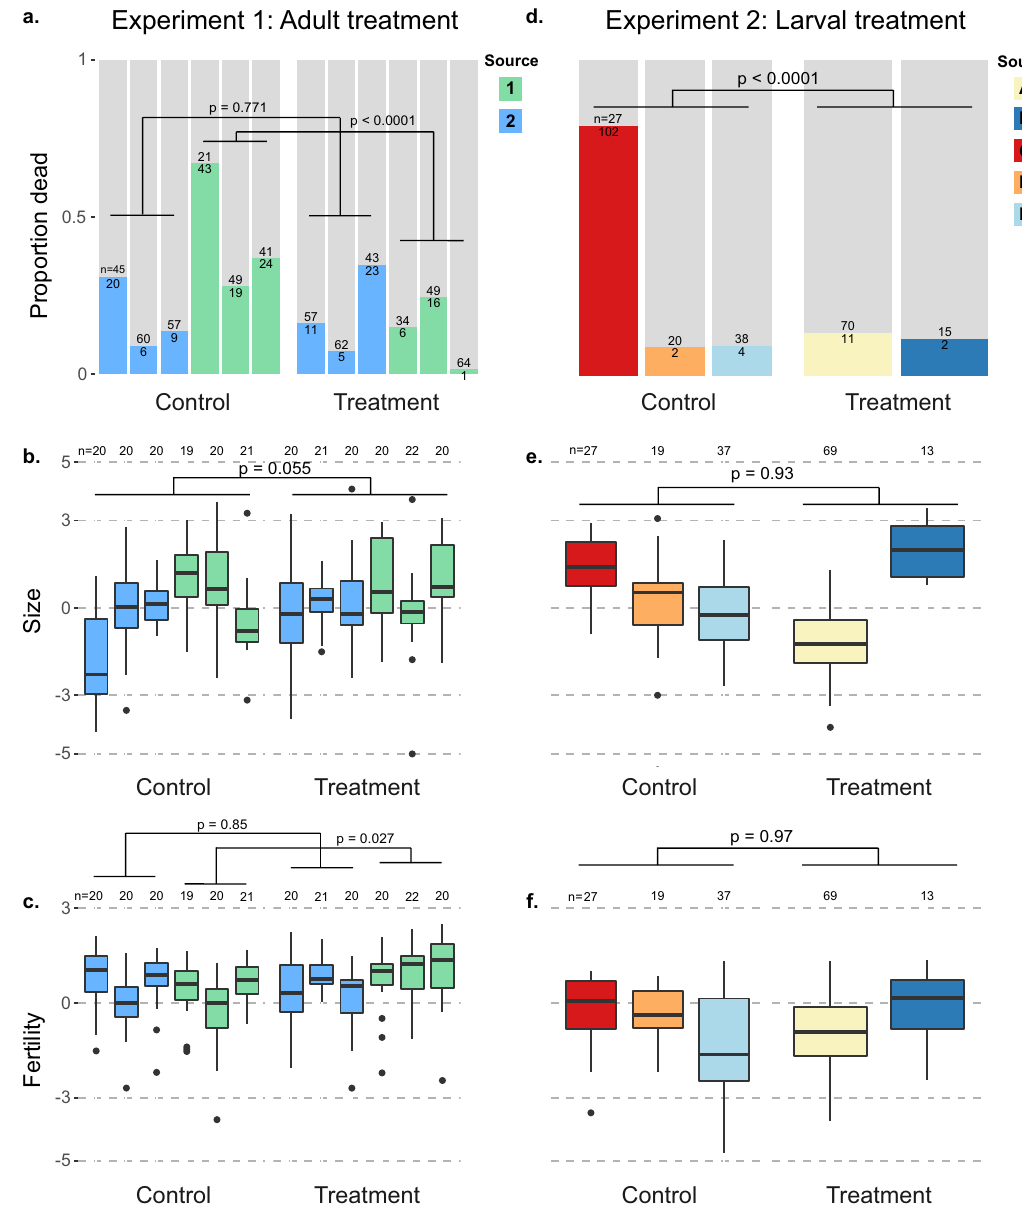
Fig. 2 No consistent effects of hive-level cocktail treatments via pollen on drone development or adult fostering. Within colonies, drones were exposed to pesticide-laced pollen patties either as adults (experiment 1) or as larvae (experiment 2). Unique drone source colonies are differentiated by colour. Mortality data are reported as proportion dead presented in colour, with live proportion presented in grey. Mortality differences were evaluated with χ 2 tests, whereas size and fertility were evaluated using linear mixed models (see Methods for speci fi c models). Boxes represent the interquartile range, bars indicate the median, and whiskers span 1.5 times the interquartile range. Sample sizes ( n ) are printed at the column break for the mortality tests ( a and d ) and along the top of each box plot ( b , c and e , f ). a – c Mortality, size, and fertility of drones from different source colonies reared in untreated colonies but fostered in either treated or untreated colonies as adults. d – f Mortality, size, and fertility of drones from different source colonies which were reared through development by treated and untreated colonies, but fostered in untreated colonies as adults. See Supplementary Data 2 for underlying morphometric data and Supplementary Data 3 for survival We identi fi ed 1452 protein groups in total (1% false discovery exposed worker comparisons, further supporting that the cocktail rate (FDR)), but after fi ltering out proteins without at least three is not hazardous to drones at these doses and under these con- ditions. Of the 34 proteins differentially expressed between imi- identi fi cations in each experimental group, 654 proteins groups dacloprid- and acetone-treated drones, 18 were also differentially were quanti fi ed. Of those, 188 were differentially expressed expressed between drones and workers (Fig. 3c – e). between drones and workers, and 34 were differentially expressed between control drones and imidacloprid-treated drones (Fig. 3a, b, all at 5% FDR, Benjamini – Hochberg correction). No differ- mitigating proteins (e.g., detoxi fi cation enzymes). We therefore ences were identi fi ed in any of the other pairwise comparisons, expected that putative stress response proteins would be including cocktail treatments relative to controls, as well as all